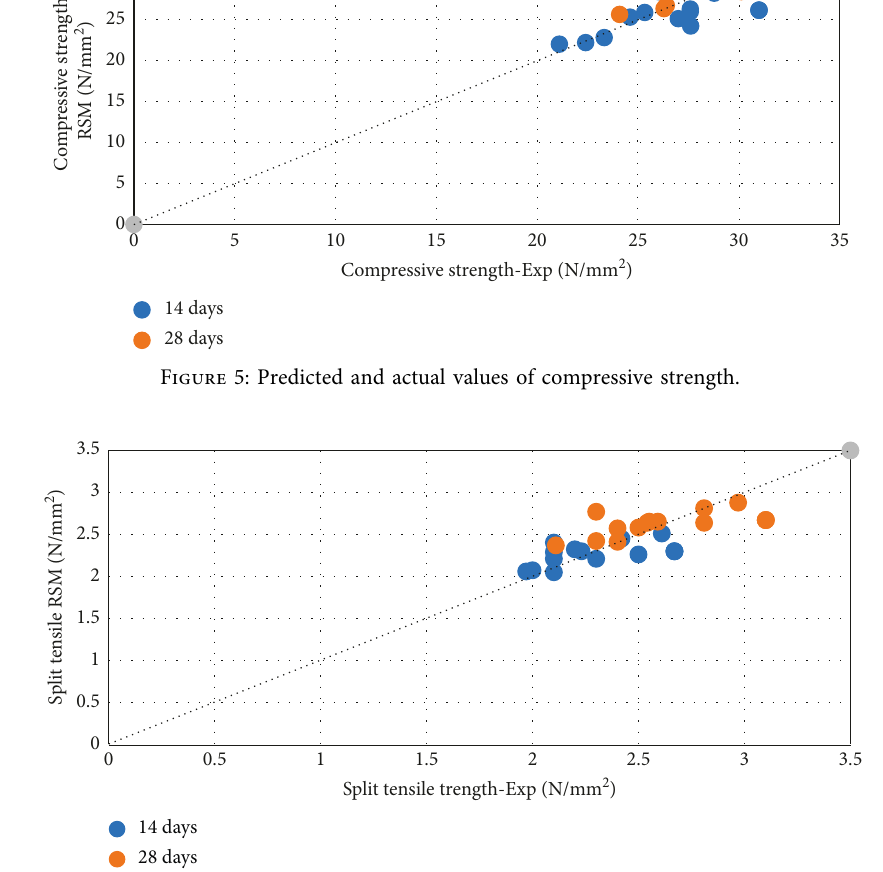
Figure 6: Predicted and actual values split tensile